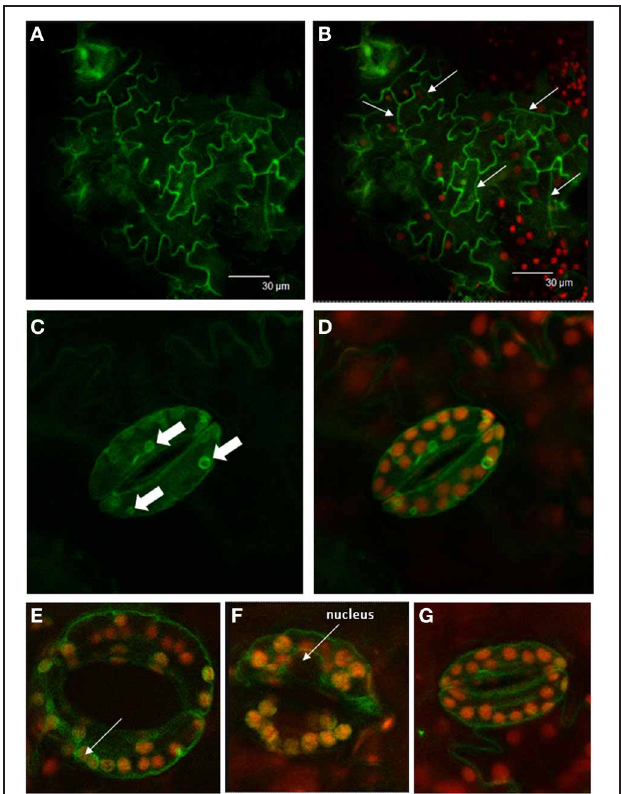
FIGURE 1 | (A) Western Blot analysis of yeast strain SUSY7 expressing StSUT4. The specificity of the StSUT4-specific polyclonal antibody generated in rabbits was tested using microsomal fractions from yeast cells expressing StSUT4 in pDR196 or the empty vector control (pDR196). The corresponding low spin pellet as well as the supernatant was loaded with Laemmli sample buffer and separated by SDS-PAGE. A band of the expected size of 46kDa is detectable only in yeast extracts expressing StSUT4. (B) Western blot analysis of NtSUT4 in different membrane fractions from tobacco source leaf material. The microsomal fraction (MF) was separated by two-phase partitioning into the endomembranes fraction (EF) and the plasma membrane fraction (PM) by two-phase partitioning as described earlier (Chincinska et al., 2008). 20 µ g of protein were loaded per lane on a 12.5% SDS gel. A band with the expected size of 46kDa was mainly detectable in the plasma membrane fraction.